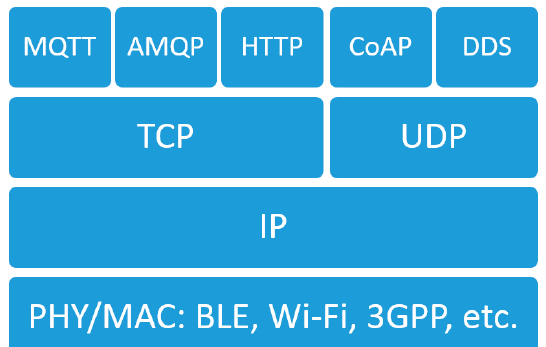
Figure 1. Different options for the IoT stack.